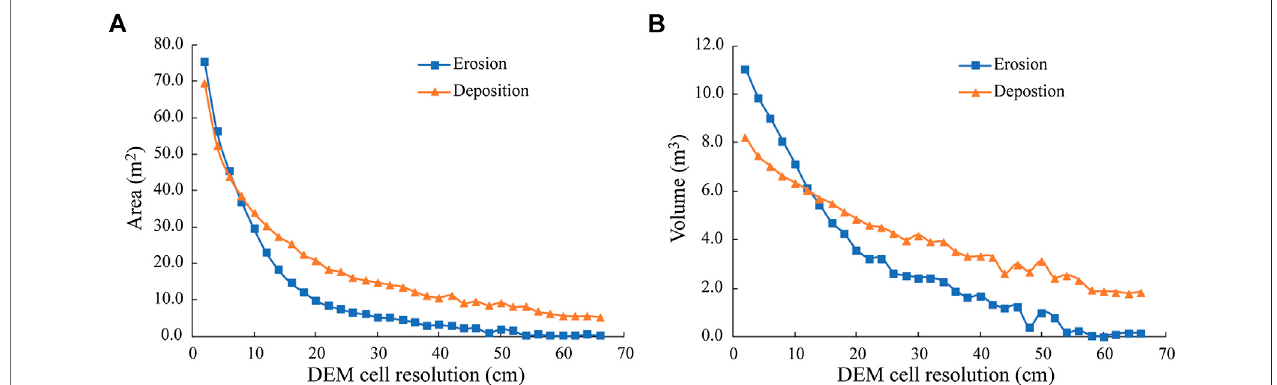
FIGURE4| Relationshipsbetweenderivedareas (A) andvolumes (B) oferosionanddepositionandDEMresolutionswiththepropagationofelevationuncertainty.